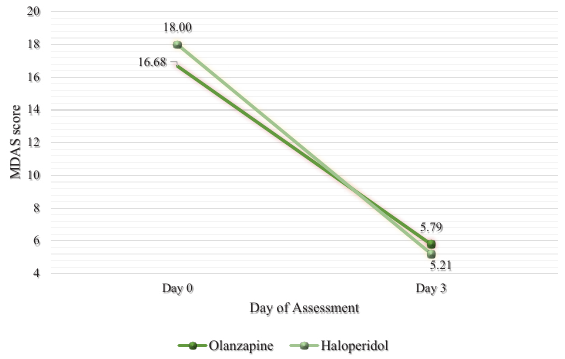
Figure 1. Comparison of MDAS scores on day 0 and 3 of the study. Figure1. Comparison of MDAS scores on day 0 and 3 of the